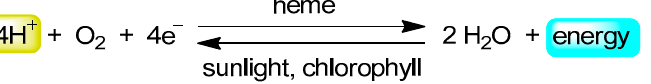
Scheme 1. Schematic representation of metalloporphyrin catalyzed basic reactions of life.